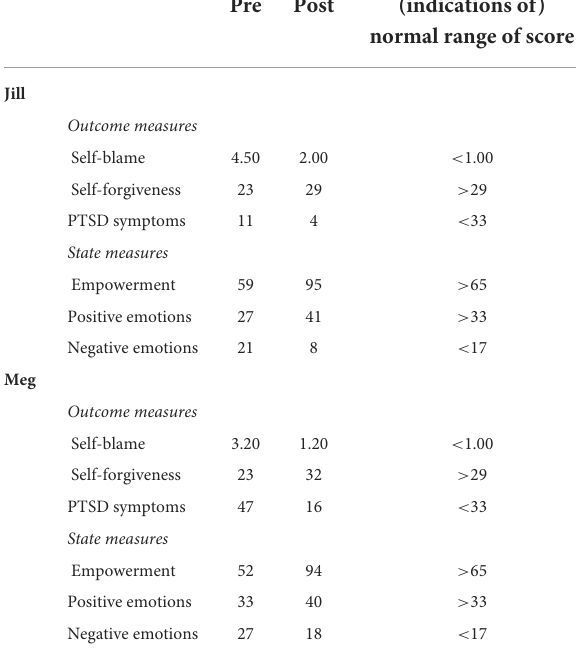
TABLE 1 Outcome and state measures during and after the deepfake